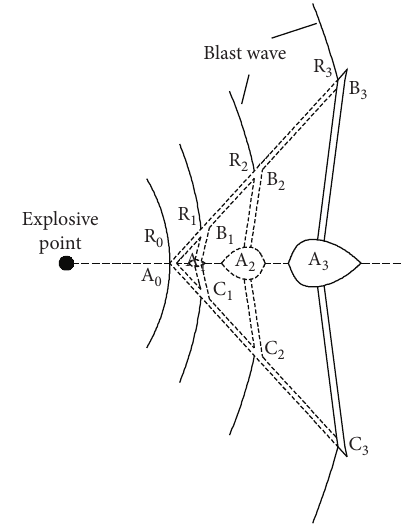
Figure 3: The formation process of shaped charge